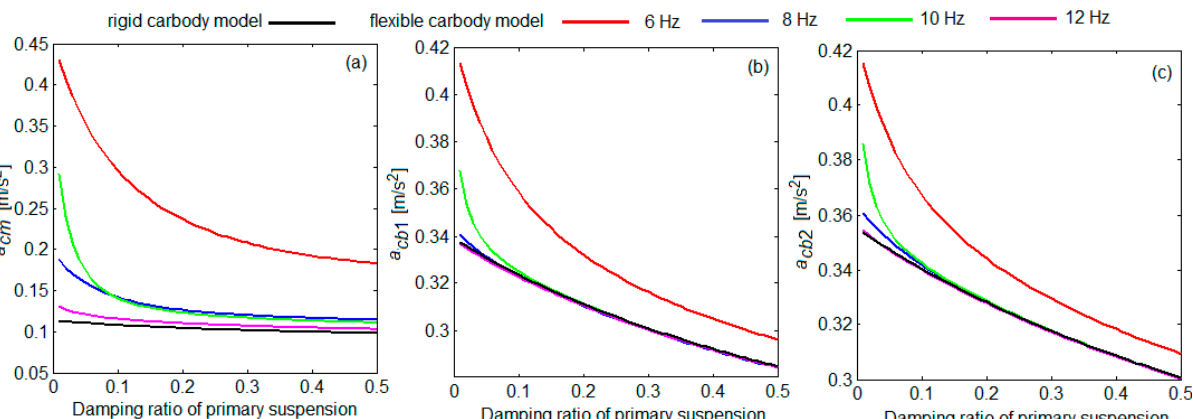
Hz). In the points located above the two bogies, the value of the damping ratio that mini-